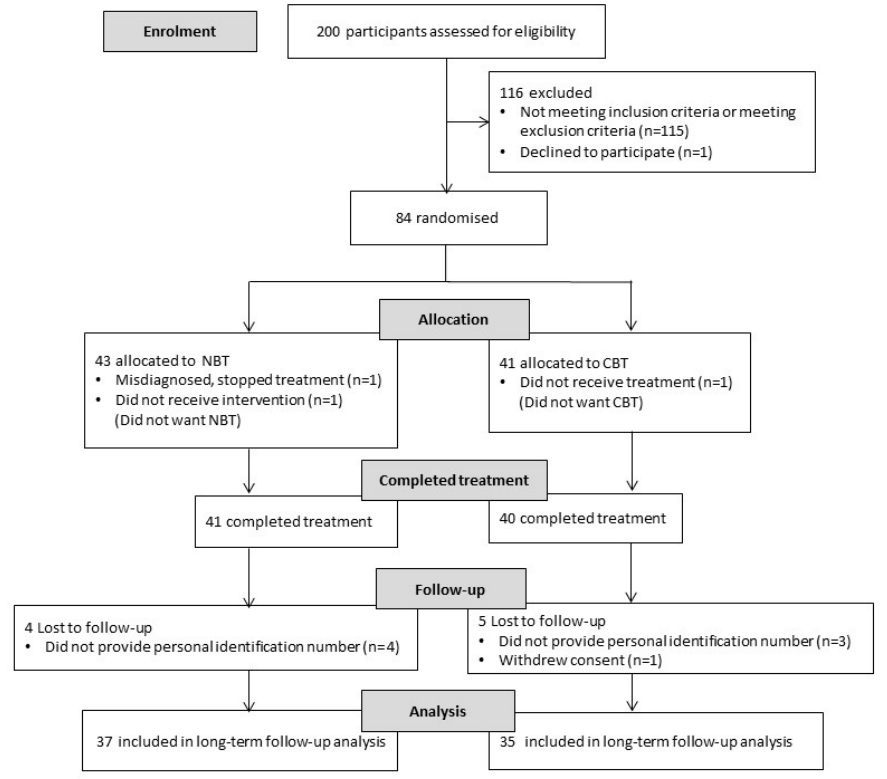
Figure 1. Participant flow